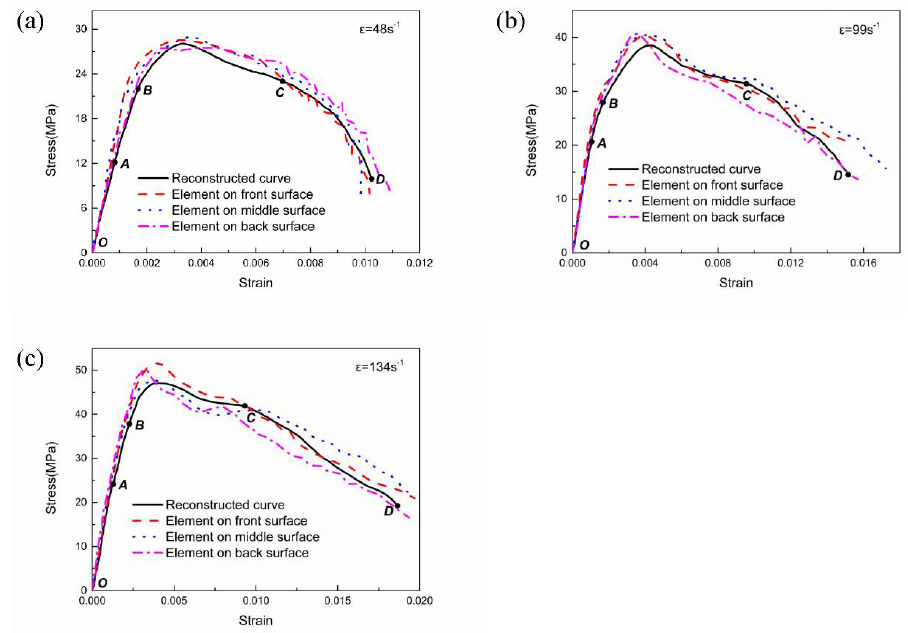
Figure 8. Stress–strain curves with different strain rates. ( a ) stress–strain curves with strain rate of 48 s −1 , ( b ) stress–strain curves with strain rate of 99 s −1 , ( c ) stress–strain curves with strain rate of 134 s −1 .